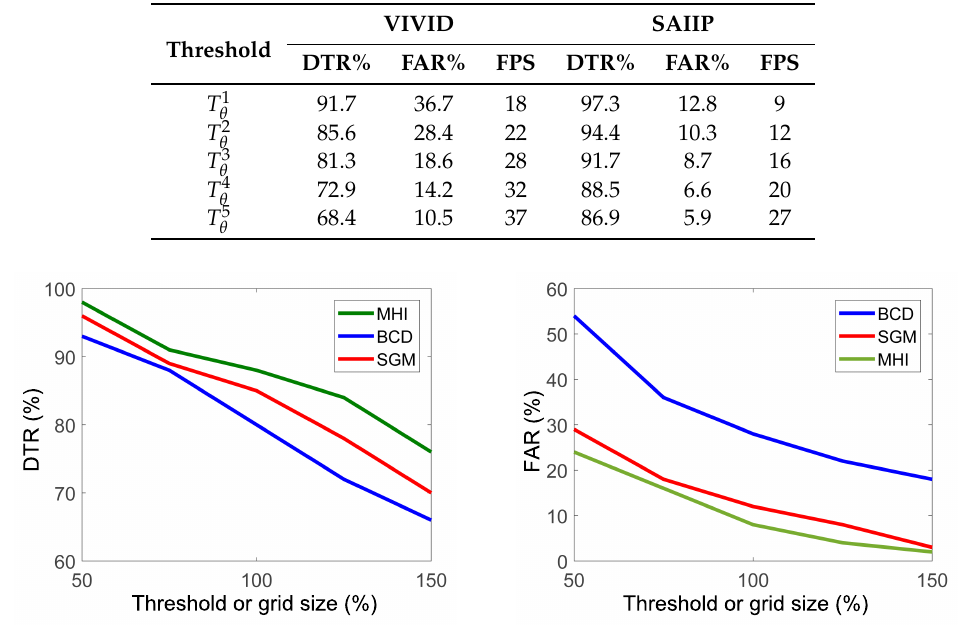
Table 2. Comparison of detection results with different detection thresholds T v FAR, False-Alarm Ratio.